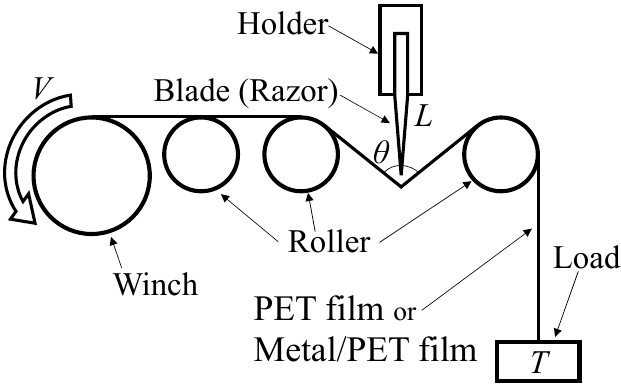
Figure 1. Schematic of the stick-slip processing device.